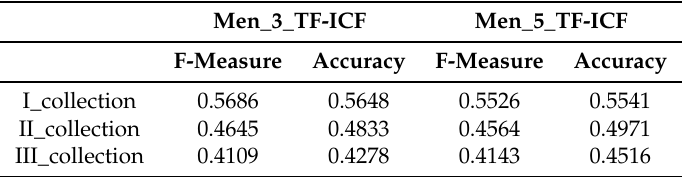
Table 3. F-measure and accuracy sentiment classification with two TF-ICF -weighed lexicons.